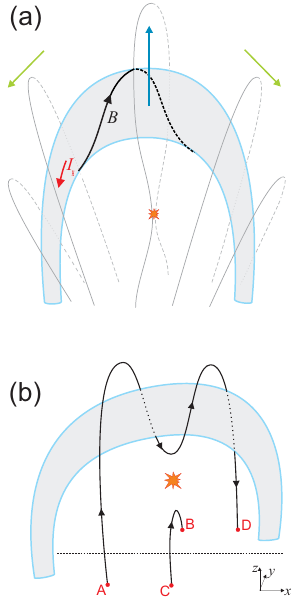
Fig. 4. (a) Schematic drawing of the eruption of a curved flux- rope (light blue) anchored at both ends in the photosphere. The overlying magnetic field is drawn in gray, internal helical field in black, electric current in red. The motion of the flux-rope (deep- blue arrow) pushes aside the overlying field (green arrows). The red explosion symbol indicates reconnection below the flux-rope axis. (b) Reconnection of strongly sheared overlying field lines. The magnetic inversion line is indicated by the dashed line oriented in the x